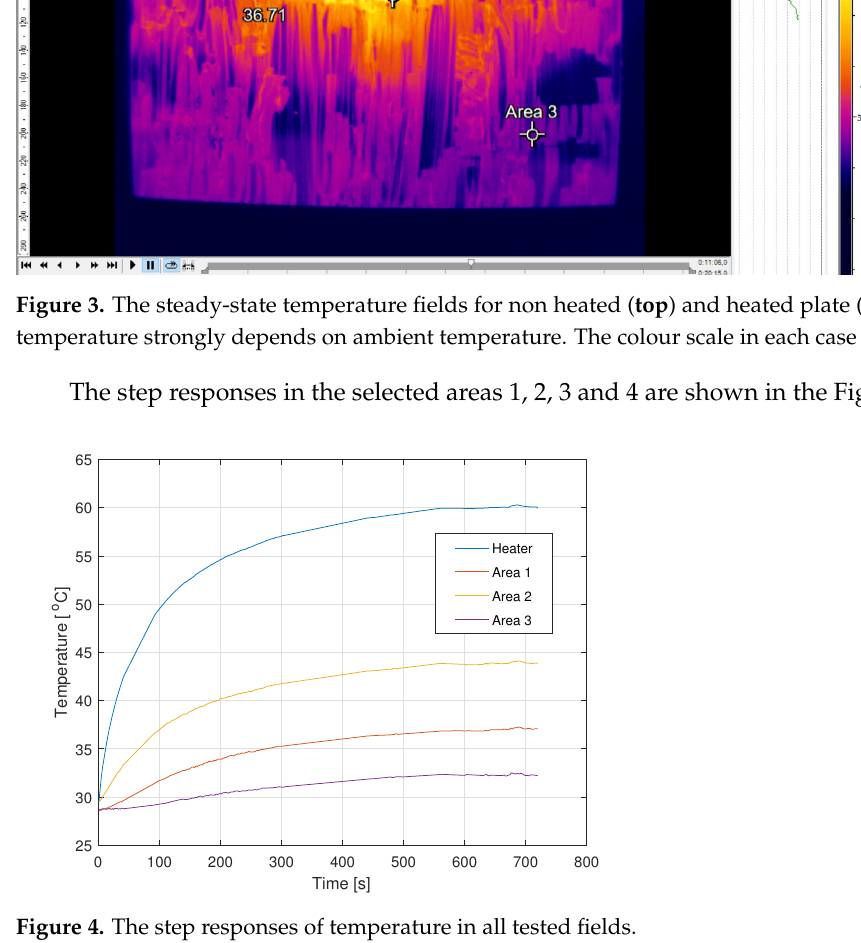
Figure 4. The step responses of temperature in all tested fields.